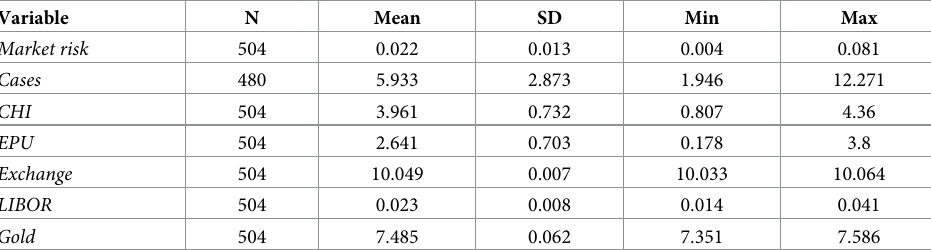
Table 7. Descriptive statistics of variables used for analysis.